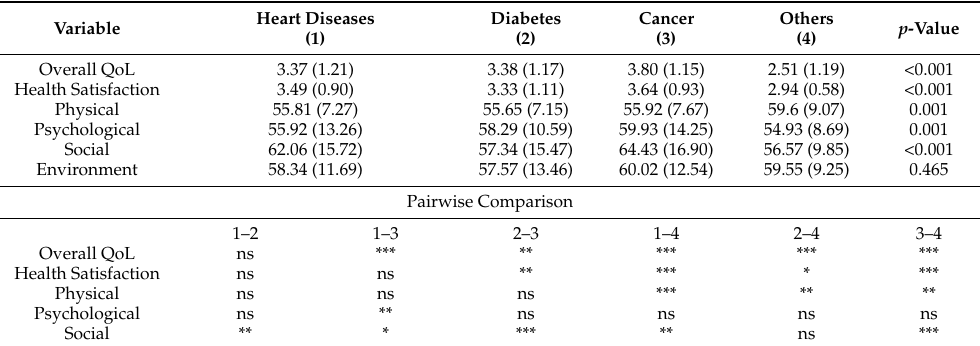
Table 5. The difference in the WHOQOL-BREF scores across different chronic diseases as assessed by Kruskal–Wallis test followed by pairwise comparison.